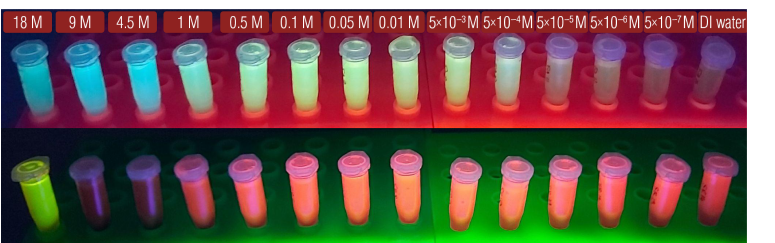
Figure 7. Fluoresceinamine (above) and sulforhodamine B in H 2 SO 4 solutions (18 M to 5 × 10 − 7 M) and in DI water under UV-light.